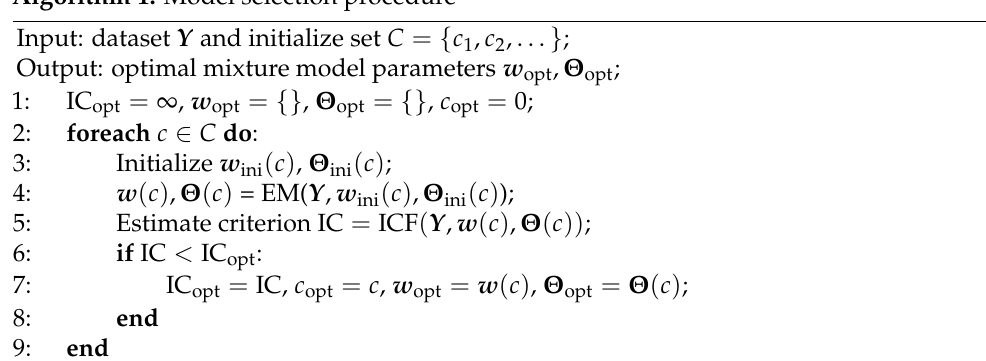
Algorithm 1: Model selection procedure